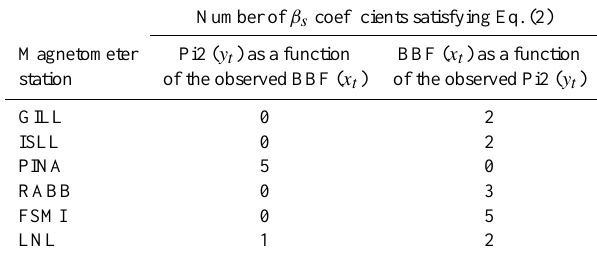
Table 3. Summarises the results from impulse response func- tion analysis between each of the individual magnetometer H- component time-series and the observed BBF v ⊥ x